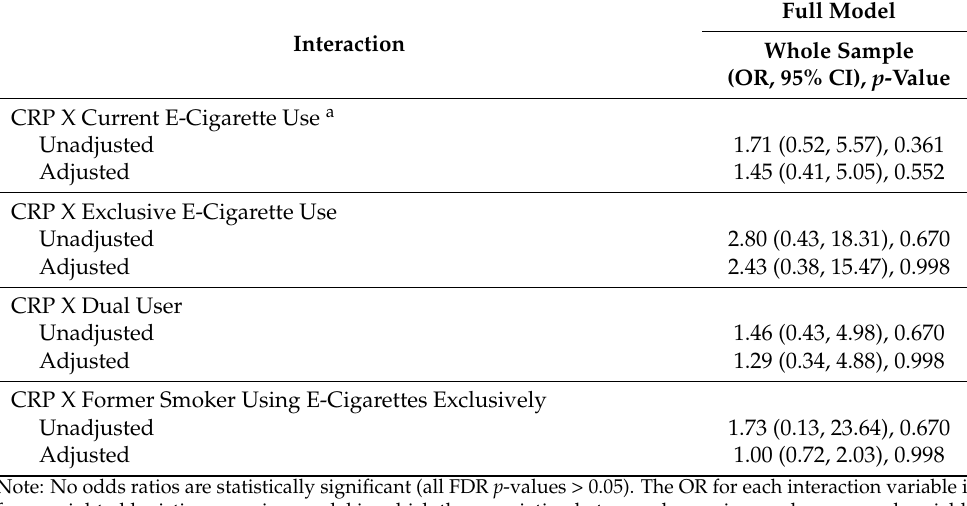
Table 5. Unadjusted and Adjusted Odds Ratios and Their Confidence Intervals (CI) from Logistic Regression Analyses Estimating the Interaction Effect of Current E-cigarette Use and C-reactive Protein on